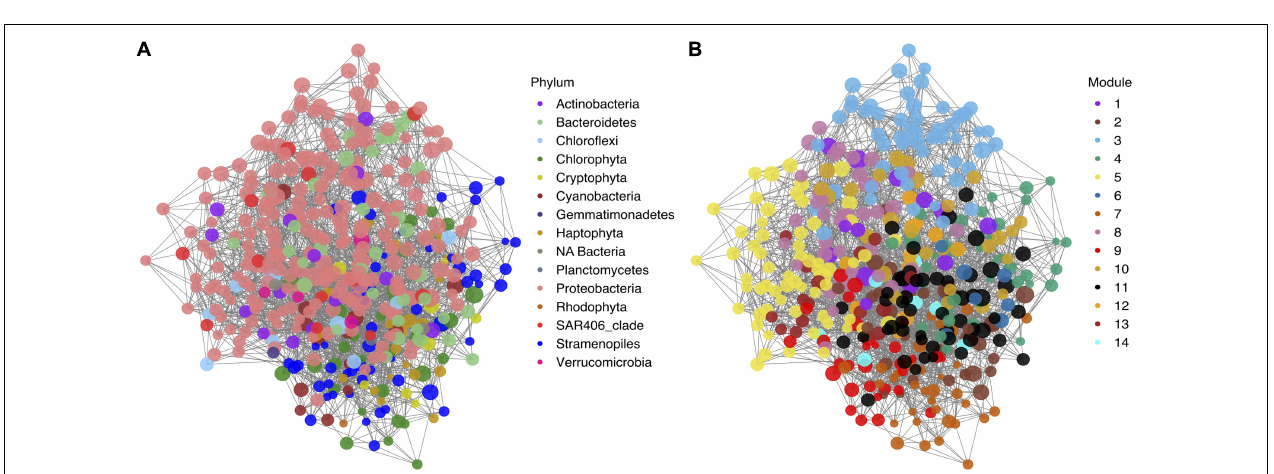
FIGURE 7 | Covariation network of the 128 phytoplankton and 292 bacterioplankton most abundant ASVs and modularity analysis. (A) Visual representation of the non-directed ASVs covariation network. Nodes are color-coded by phylum. (B) Visual representation of the non-directed ASVs covariation network with the nodes color-coded by module. Size of the nodes in both panels depicts the log2 of the represented ASV